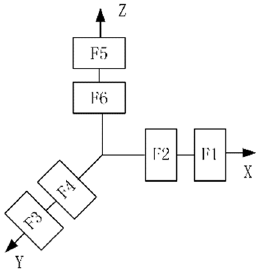
Figure 9. Configuration of six-orthogonal flywheels.